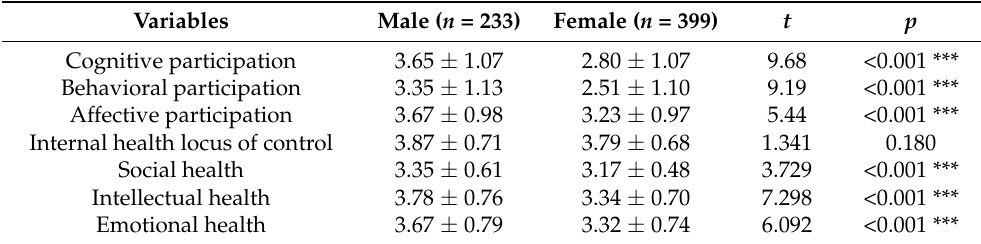
Table 5. Sex differences in all